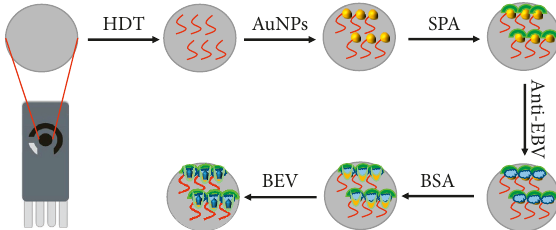
Figure 1: Scheme of electrochemical immunoassay